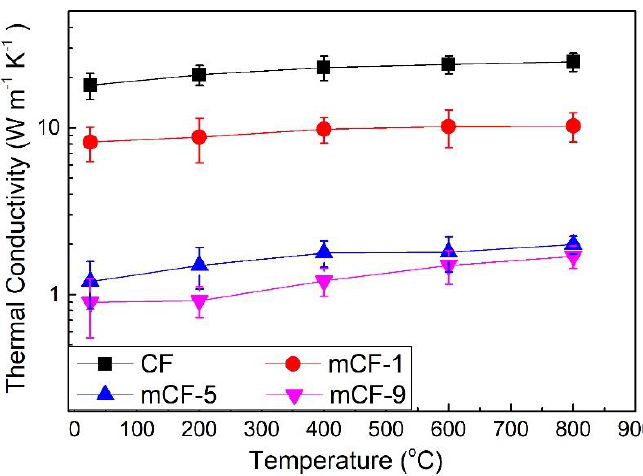
Figure 7. Comparison of thermal conductivity of pristine CF and mCF materials with di ff erent PR additive.